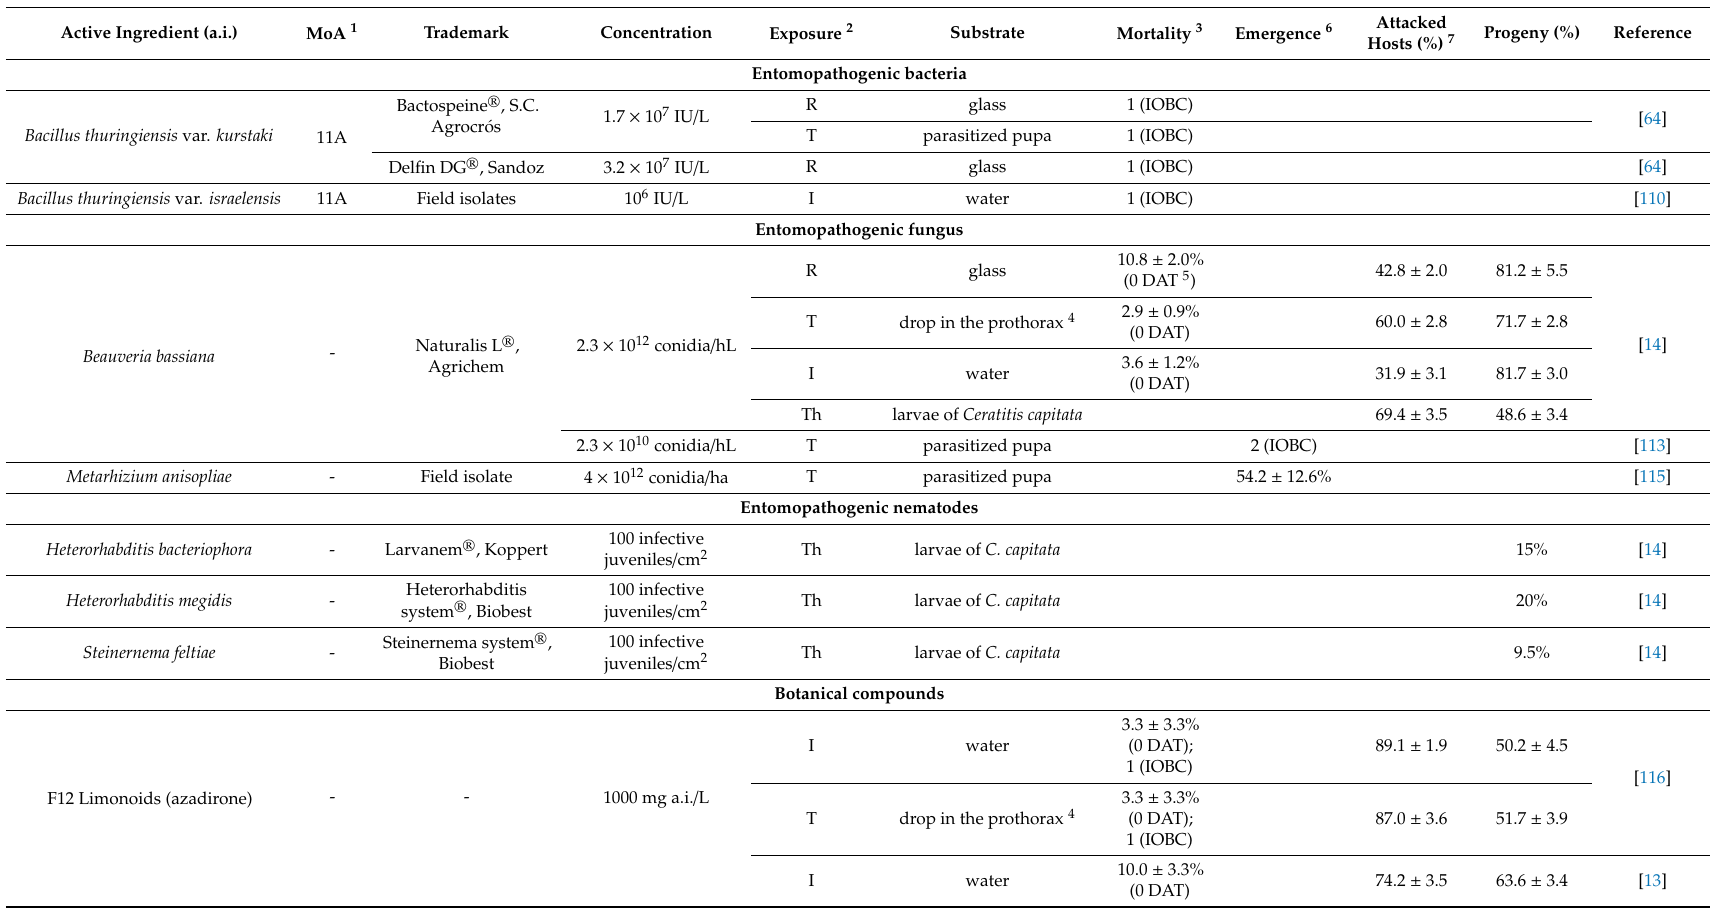
Table 4. Toxicity of microbial insecticides and botanical compounds tested on Psyttalia concolor